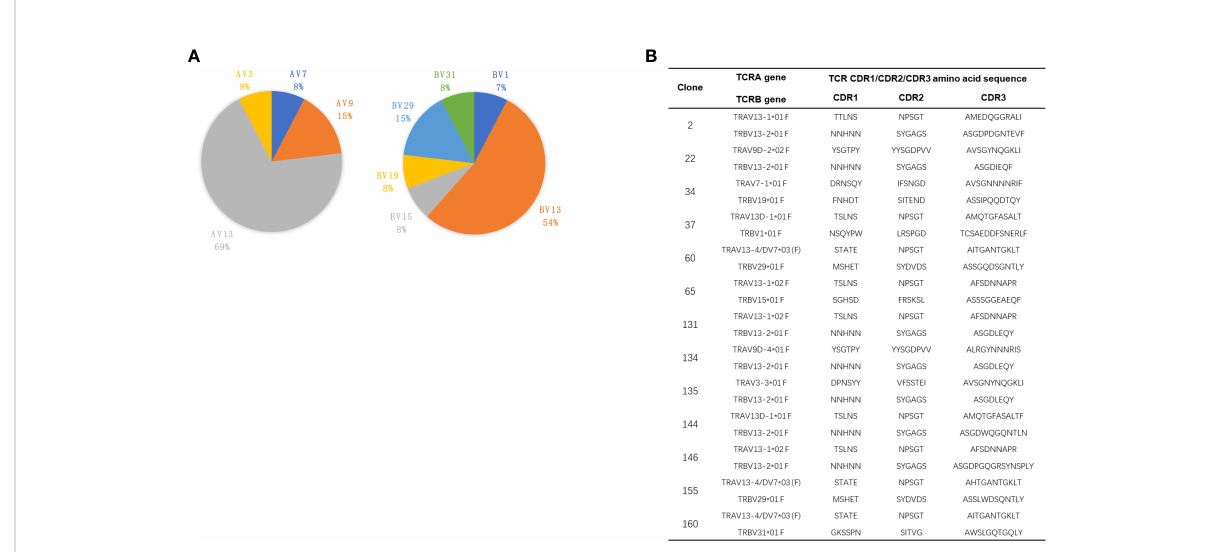
FIGURE 6 TCRVgeneusagesofCGRP speci fi cTcell hybridomas. (A) Piechartsshowedthefrequencyof TRAV(left)andTRBV(right)gene segment usage of 13